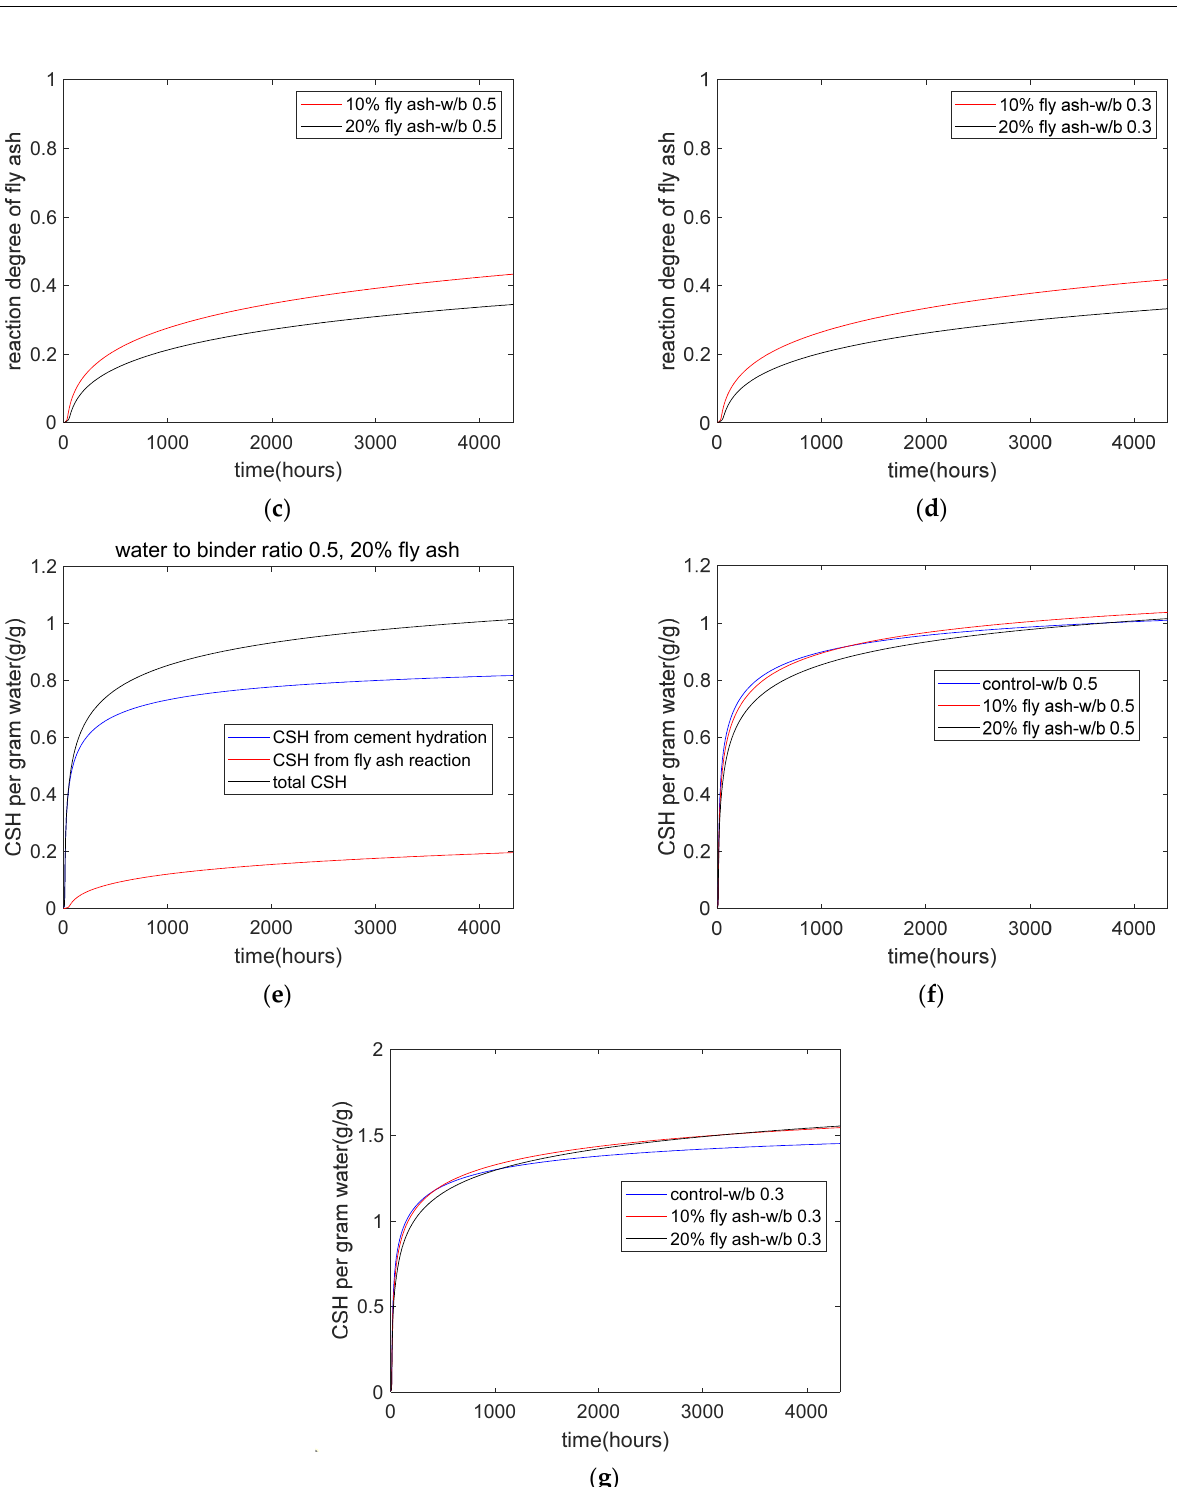
Figure 2. Parameter study of hydration model. ( a ) Degree of hydration of cement (W/B, 0.5). ( b ) Degree of hydration of cement (W/B, 0.3). ( c ) Degree of reaction of fly ash (W/B, 0.5). ( d ) Degree of reaction of fly ash (W/B, 0.3). ( e ) CSH components from reactions of fly ash and cement. ( f ) CSH per gram of water (W/B, 0.5). ( g ) CSH per gram of water (W/B, 0.3).